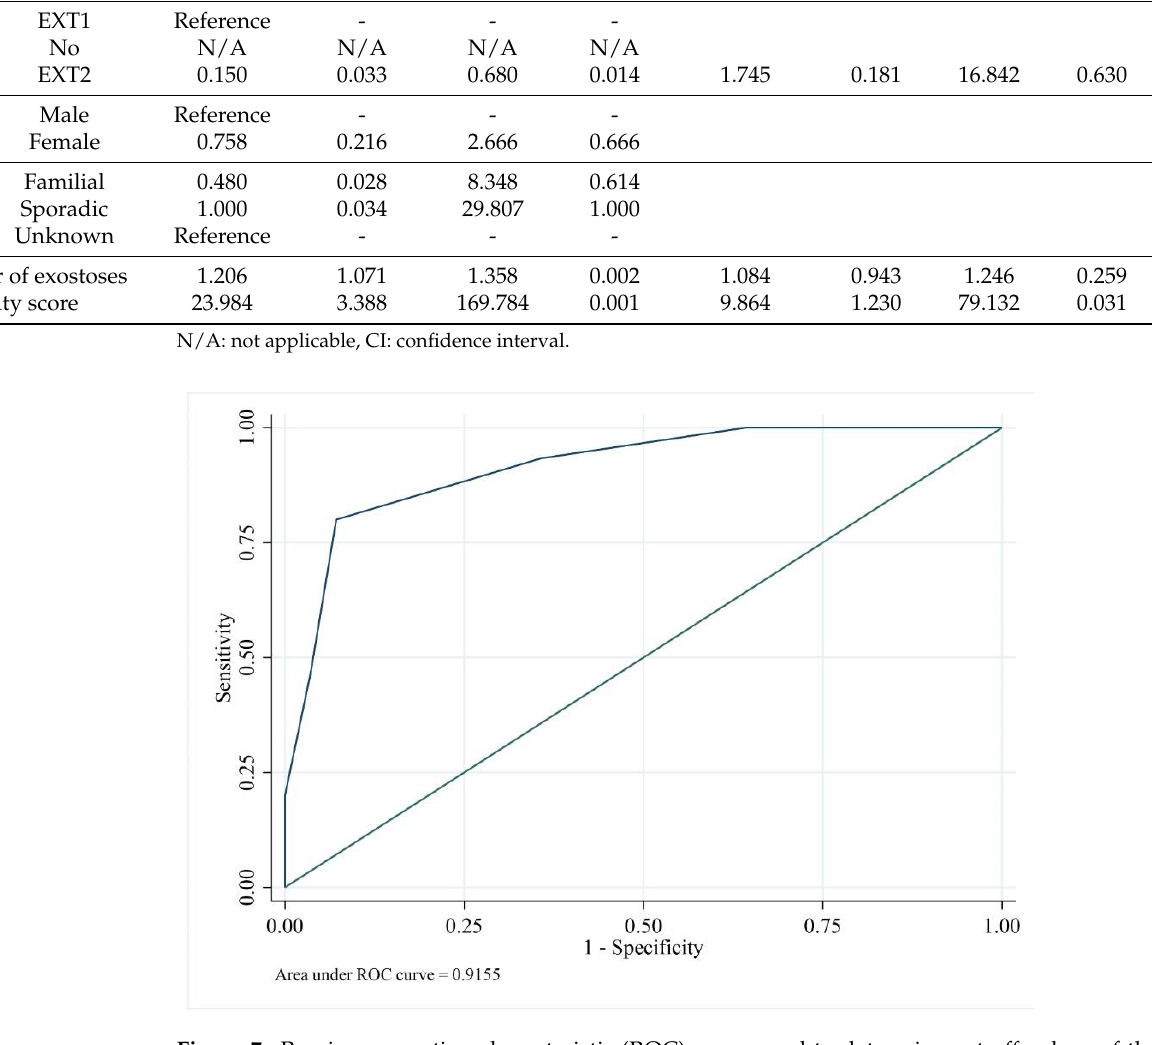
Figure 7. Receiver operating characteristic (ROC) curve used to determine cut-off-values of the deformity score. The deformity score was the only factor which showed association with the ‘severe’ class phenotype ( p = 0.031) in the multivariate analysis. The deformity score of 1.5 or higher was noted to be threshold for having the ‘severe’ class with 0.9155 of AUC.